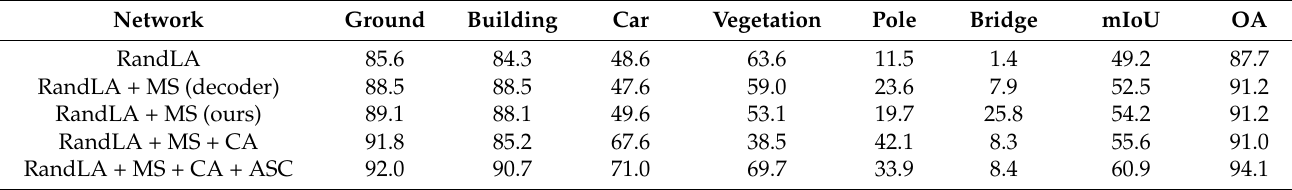
Table 6. The ablation study results of CSPC dataset. Scene 1, 3, and 4 consisted of the training set and scene 2 and 5 consisted of the testing set. RandLA: RandLA-Net; MS: Multi-Scale Aggregation; CA: Channel Attention; ASC: Attentive Skip Connection. Network Ground